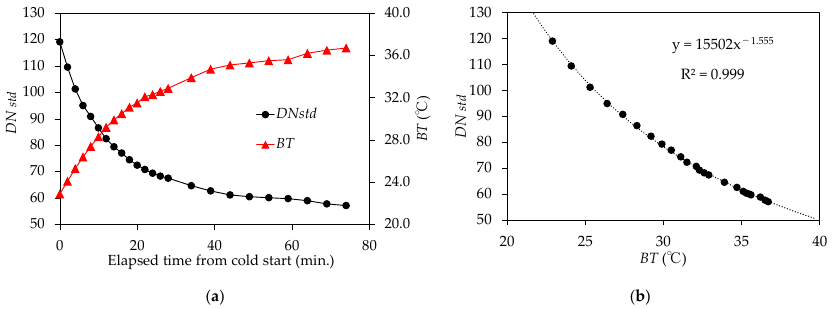
Figure 4. Changes over time in the DN of the standard reflection panel ( DN std ) related to the body temperature of the LiDAR ( BT ). ( a ) Changes over time in the DN std and the BT after a cold start; ( b ) Correlation between the DN std and the BT . The dashed line denotes the regression line.